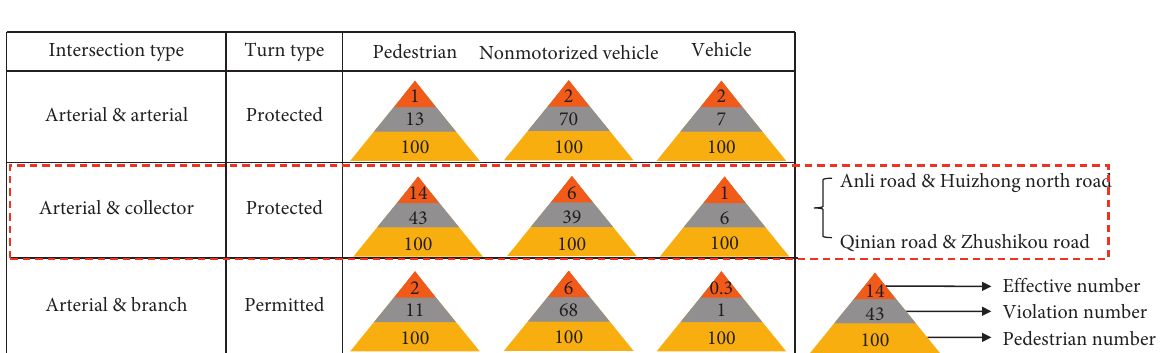
Figure 3: Violation pyramids. Note: protected: go straight and turn left at the same time; permitted: go straight and turn left at the different time.